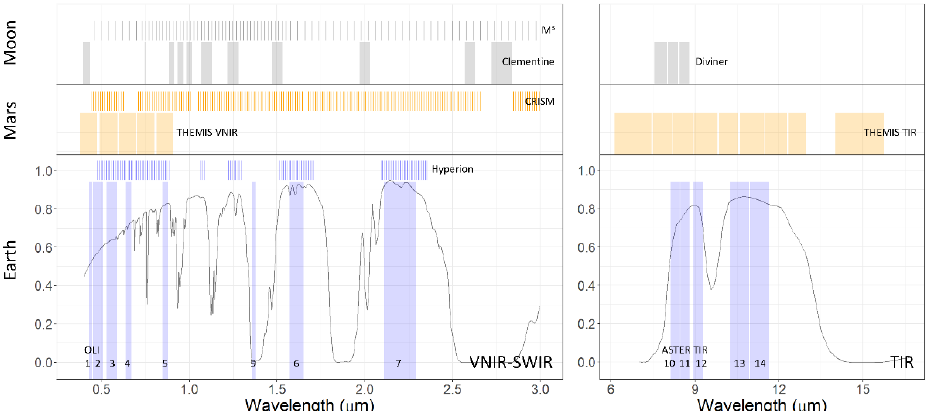
Figure 1. Overview of selected spectral bands of remote sensing instruments for the Earth, Moon, and Mars mentioned in this work in VNIR-SWIR and TIR ranges. Blue, orange, and gray colors correspond to instruments for the Earth, Mars, and the Moon, respectively. For the Earth component, the atmospheric transmittance computed with MODerate resolution atmospheric TRANsmission (MODTRAN) for one-way US standard 1976 model [38] is also shown. Band numbers for Landsat 8 OLI and Terra ASTER TIR are indicated at the bottom. Table 1. Landsat 8 OLI band ratios from Rockwell et al. [36] used to characterize iron-bearing and alteration minerals.